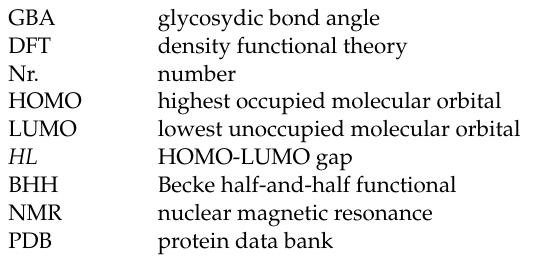
Table S1: Pearson’s correlation coefficients [31] between structural and electronic parameters. Figure S1: Gaussian fits of statistical